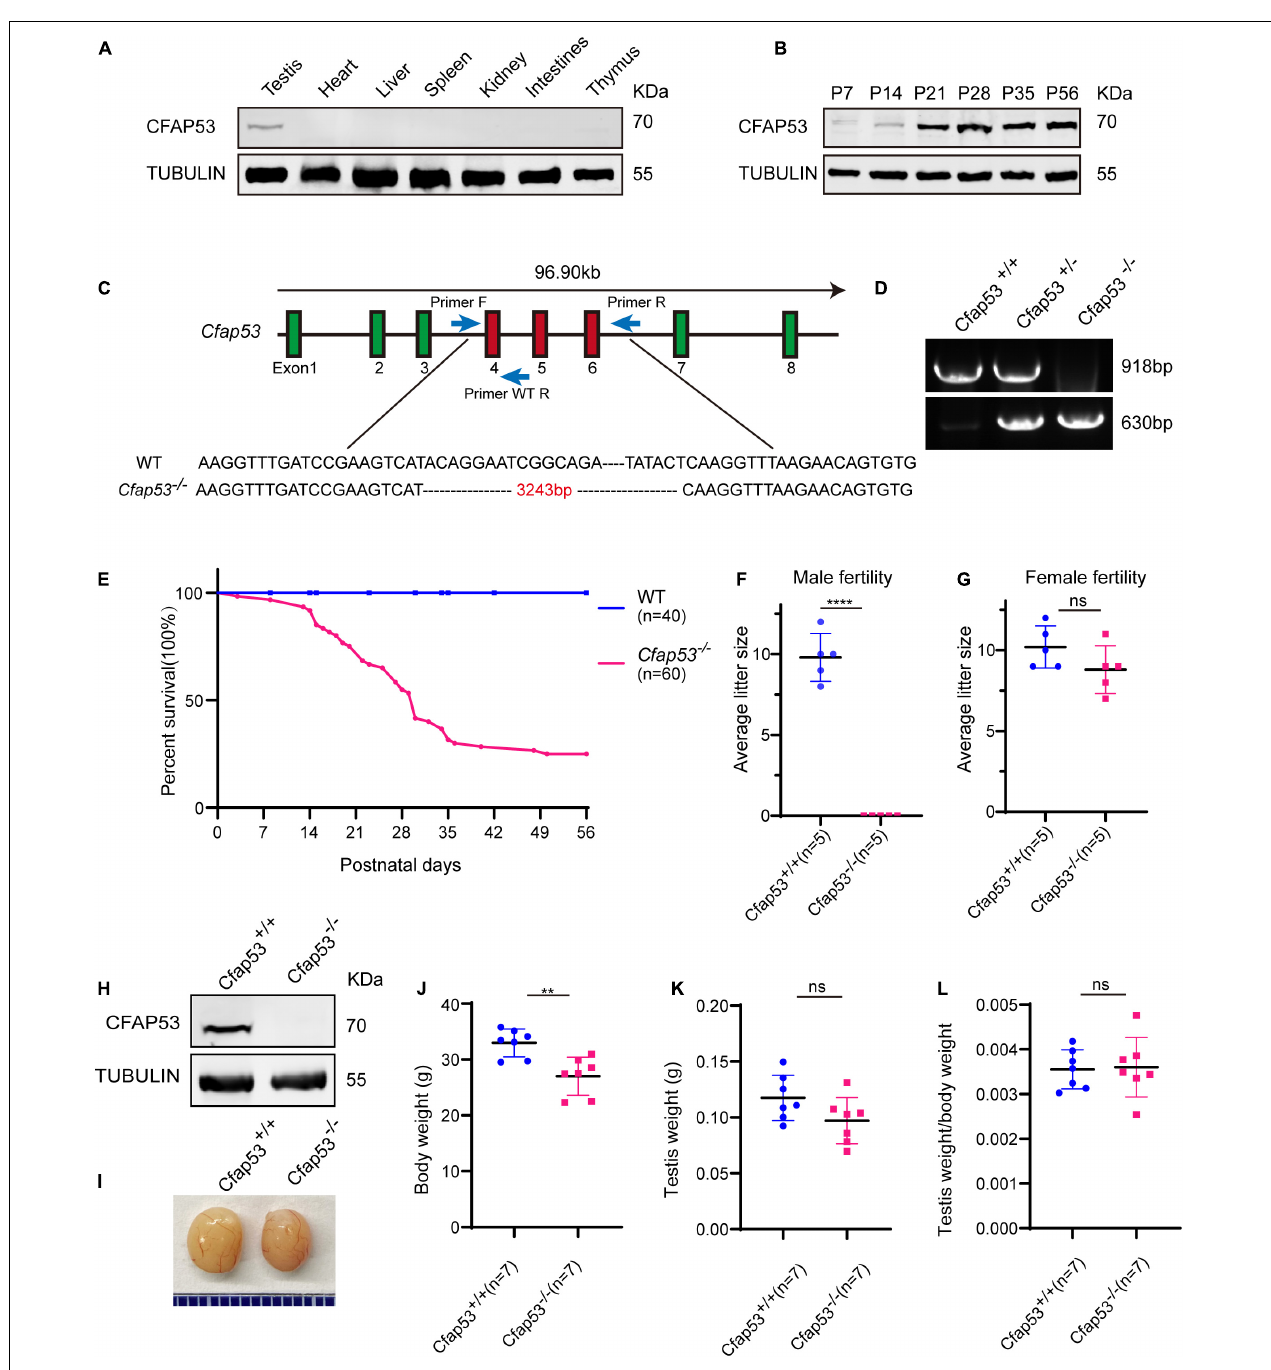
FIGURE 1 | The generation of Cfap53 knockout mice. (A) CFAP53 was predominately expressed in testis. Immunoblotting of CFAP53 was performed in testis, heart, liver, spleen, kidney, intestines, and thymus with Tubulin serving as the control. (B) CFAP53 was expressed starting in P7 testes. Tubulin served as the control. (C) The generation of Cfap53 knockout mice lacking exons 4–6. (D) Genotyping of Cfap53 knockout mice. (E) Survival rate of postnatal Cfap53 − / − mice ( n = 60). (F) The average litter size of Cfap53 + / + and Cfap53 − / − male mice at 3 months ( n = 5 independent experiments). Cfap53 − / − male mice were completely sterile. Data are presented as the mean ± SD. **** P < 0.0001. (G) The average litter size of Cfap53 + / + and Cfap53 − / − female mice at 3 months ( n = 5 independent experiments). Cfap53 − / − female mice were fertile. Data are presented as the mean ± SD. (H) Immunoblotting of CFAP53 in Cfap53 + / + and Cfap53 − / − testes. Tubulin served as the control. (I) The testis sizes of Cfap53 + / + and Cfap53 − / − mice were similar to each other. Data are presented as the mean ± SD. (J) The body weights of Cfap53 − / − male mice were lower compared to Cfap53 + / + male mice ( n = 7 independent experiments). Data are presented as the mean ± SD. ** P < 0.01. (K) The testis weights of Cfap53 + / + and Cfap53 − / − male mice ( n = 7 independent experiments). Data are presented as the mean ± SD. (L) The ratio of testis weight/body weight in Cfap53 + / + and Cfap53 − / − male mice ( n = 7 independent experiments). Data are presented as the mean ± SD.